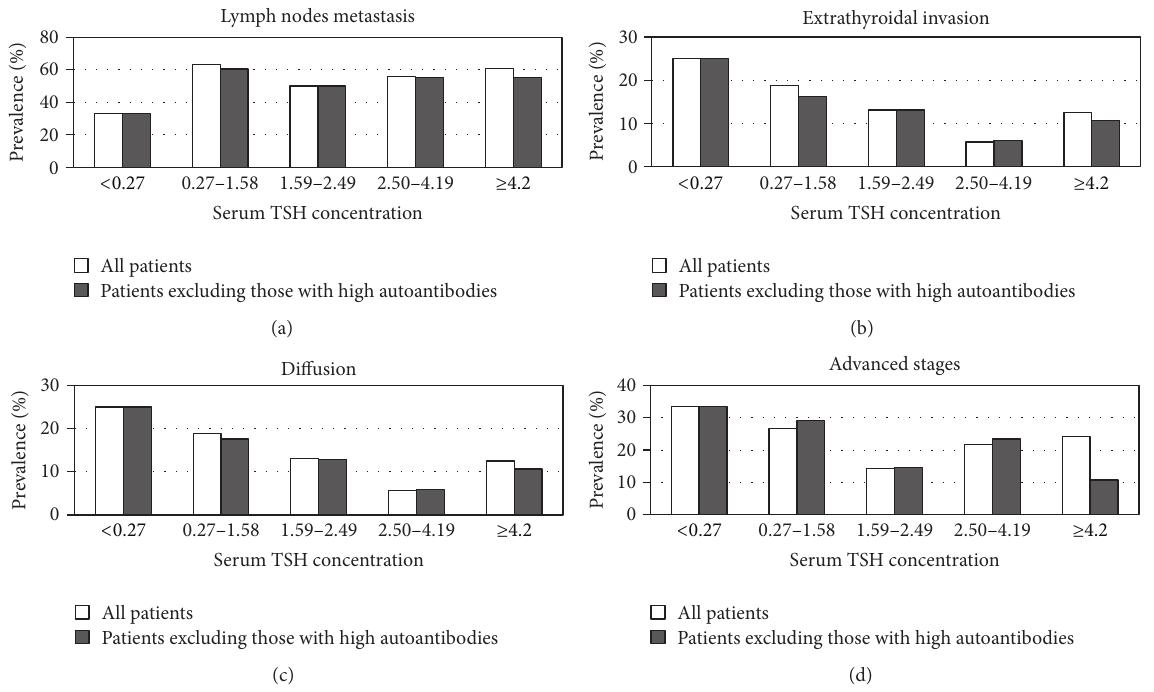
Figure 4: Association of serum TSH concentration and clinicopathological characteristics in differentiated thyroid